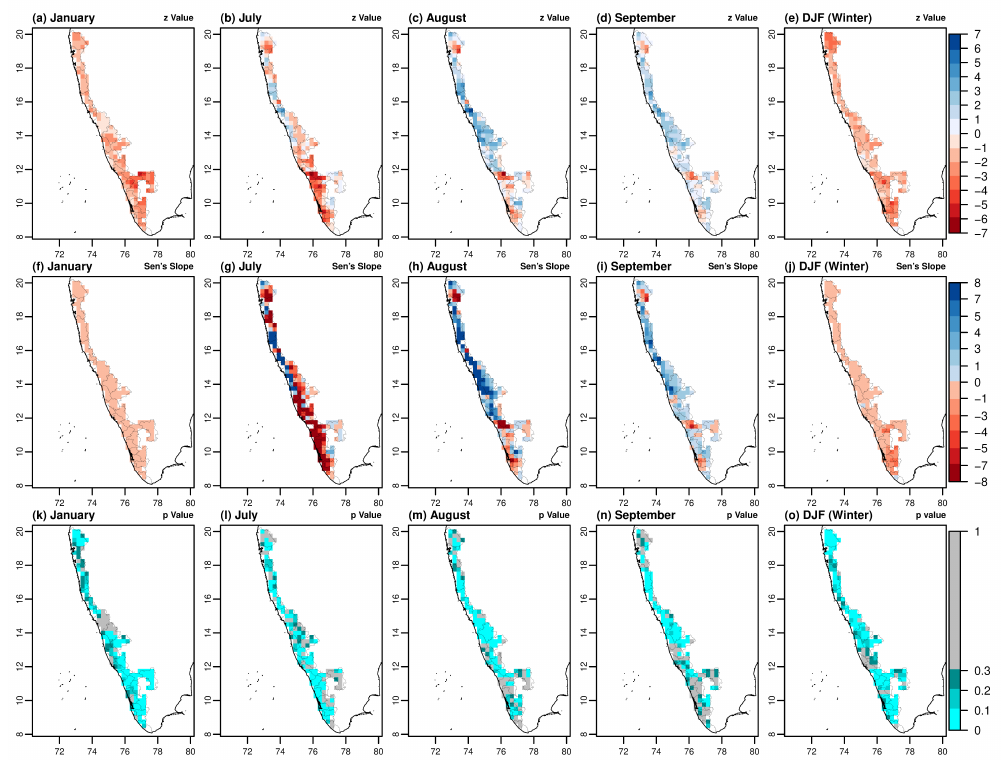
Figure 5. Spatial distribution of MMKT z value ( a – e ), Sen’s slope value ( f – j ) and p -value in ( k – o ) showing significance level of the result shown in ( a – e ) and ( f – j ). MMKT z value is in mm and unit of Sen’s slope value is mm year − 1 .